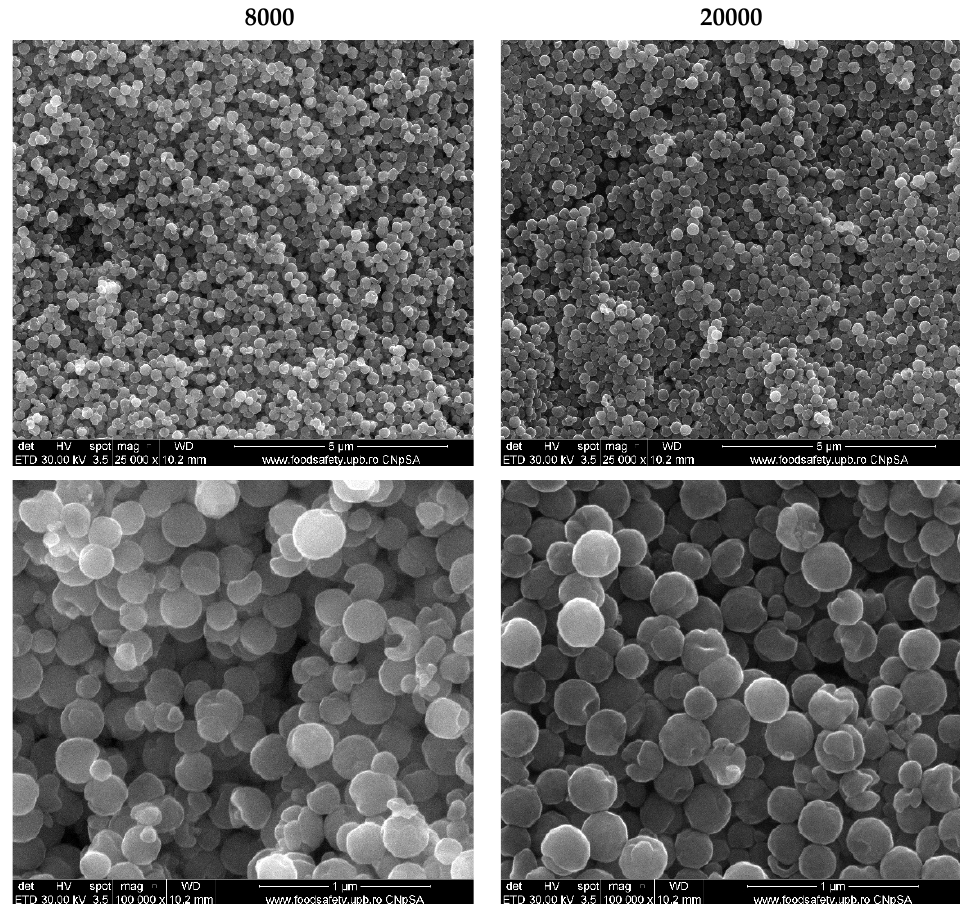
Figure 3. SEM images of the two types of magnetite microspheres.